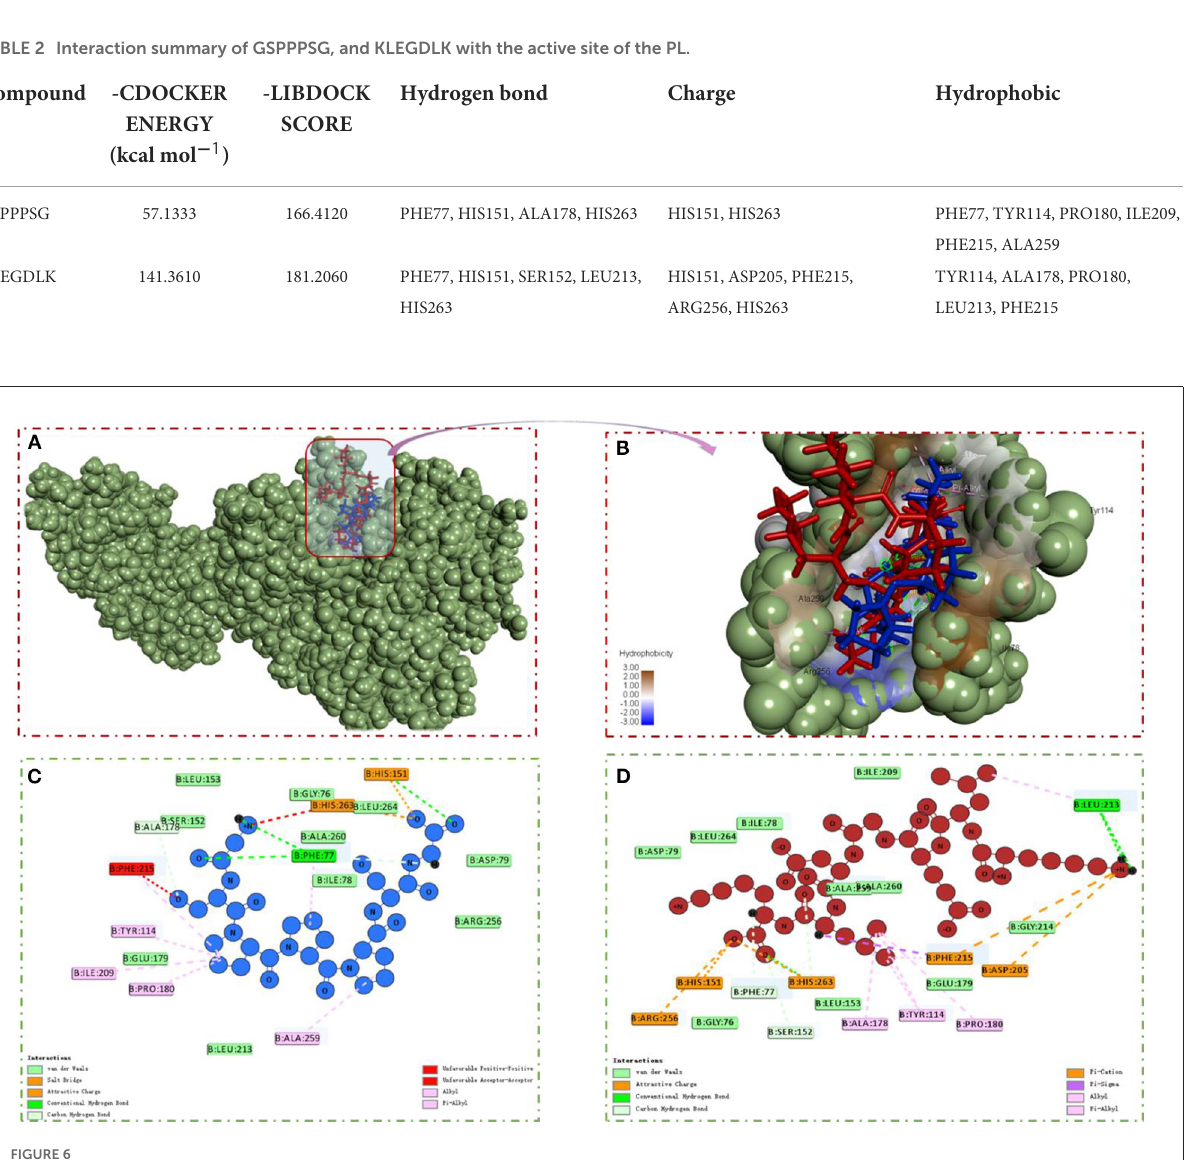
FIGURE6 (A,B) PL-GSPPPSG&KLEGDLK complex. (C) 2D diagram showing interactions between GSPPPSG and PL amino acid residue. (D) 2D diagram showing interactions between KLEGDLK and PL amino acid